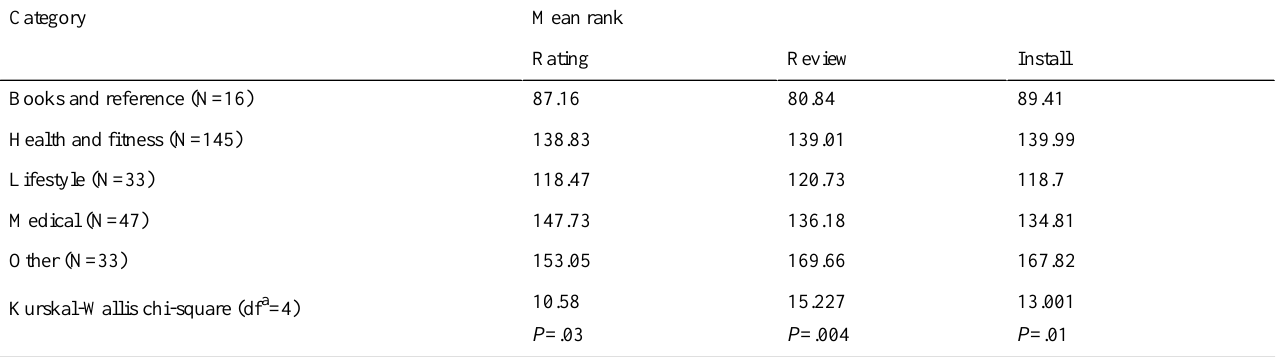
Table 3. Kruskal-Wallis test for price, rating, review, install, and permission requests by apps